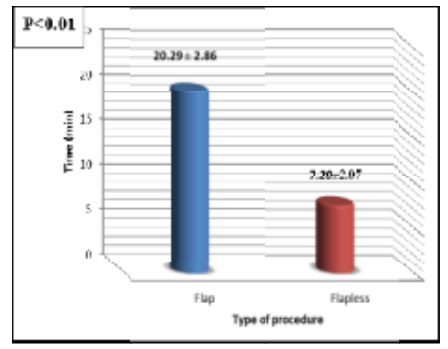
Fig.7: Time of surgical operation for